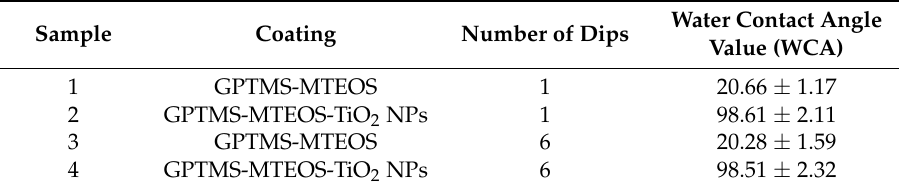
Table 2. Summary of the different sol-gel hybrid coatings of the study as a function of two experimental variables, the presence of additives (TiO 2 NPs) and number of dips (1 and 6), with their corresponding water contact angle (WCA) values.